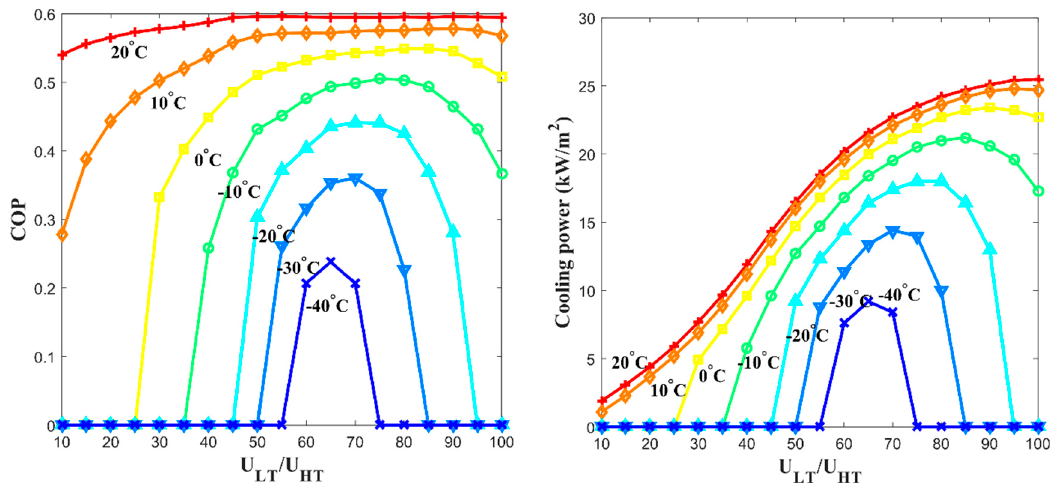
Figure 9. Performance of the proposed metal hydride thermal conversion system affected the ratio of the free thermal wave velocity in the low-temperature channel to the corresponding velocity in the high-temperature channel ( U LT / U HT ), which a ff ected the ( left ) COP cool ; and ( right ) specific cooling power at various ratios between free thermal wave velocities.